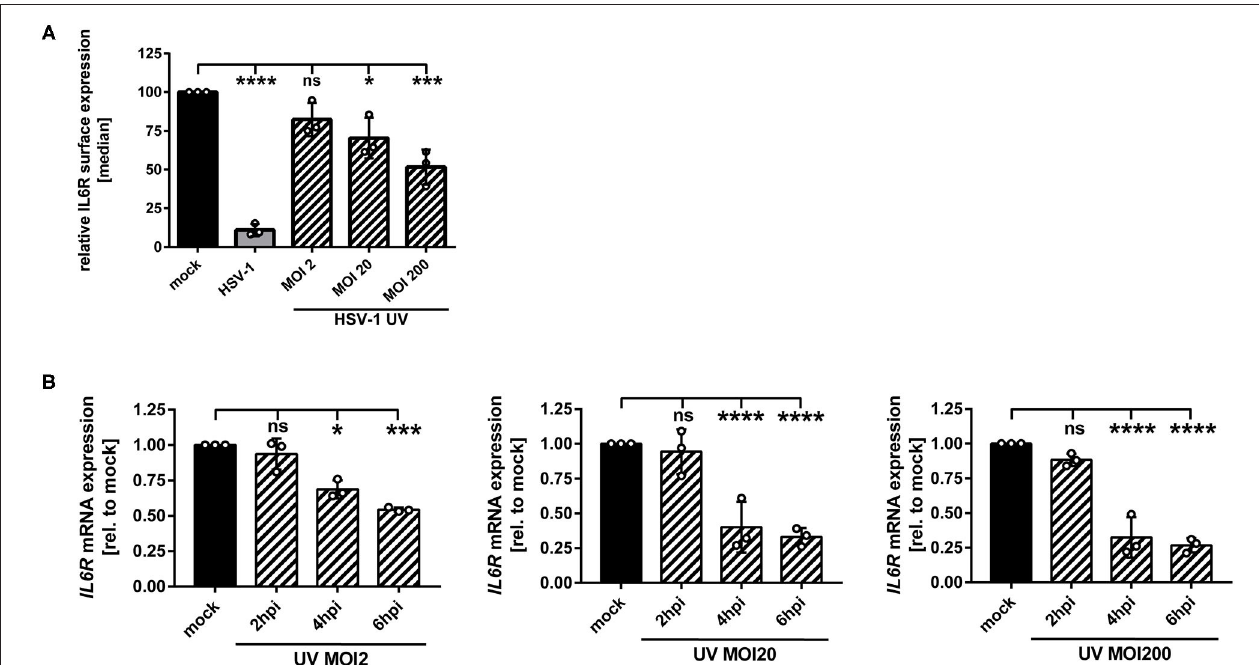
FIGURE 4 | HSV-1 induces IL6R modulation via a replication-independent mechanism. (A,B) Mature DCs were mock-treated (black bars) or HSV-1 wt-infected (MOI of 2, gray bars) or incubated with UV-inactivated HSV-1 virions using the indicated MOIs (viral material corresponding to MOI of 2, 20, 200, irradiated 8 times applying 0.12 J/cm 2 , black dashed bars). (A) Cells were harvested 24 hpi, stained with an IL6R-specific antibody and surface expression was analyzed via flow cytometry. The median of IL6R surface expression was normalized to the expression levels of mock treated cells. The experiment was performed three times with cells derived from different healthy donors. (B) Cells were harvested 2, 4, 6 hpi. RNA was isolated and qPCR was performed using transcribed cDNA. Relative IL6R mRNA expression levels are normalized to S14 and shown relative to the respective mock condition. The experiment was performed three to seven times with cells derived from different healthy donors. Error bars indicate SD. Significant changes to mock were analyzed using a one-way ANOVA and Bonferroni multiple comparison post hoc tests and are indicated by asterisks (* p ≤ 0.05, *** p ≤ 0.001, **** p ≤ 0.0001). Not significant changes ( p > 0.05) are depicted as “ns”.